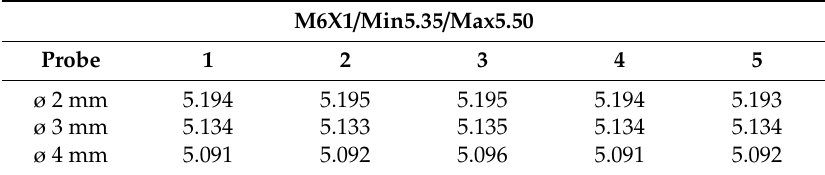
Table 1. Diameters of the thread resulted by measuring using 3 probes and 5